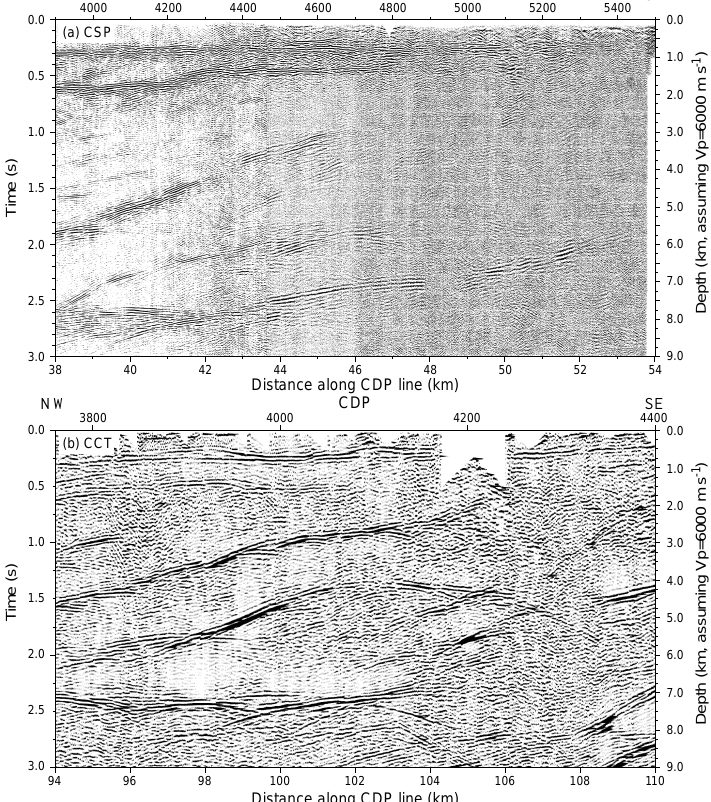
Figure 8. Sections of the CSP (top) and CCT profile (bottom) over approximately the same structural location. The three prominent reflective zones between 1 and 3s on the western halves of the profiles are interpreted to represent the same structures. The transparent zone between 0.5 and 2s on the eastern half of the CSP is interpreted as due to poor S/N because of the thick sequence of loose sediments at the surface along this portion of the profile. Although data quality is variable at the equivalent location on the CCT profile, clear reflections are present between 0.5 and 2s. It is likely that with better quality data, clear reflections would also be observed on the eastern half of the CSP between 0.5 and